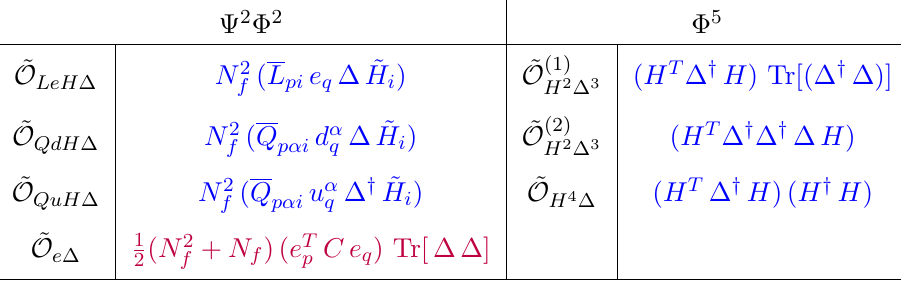
Table 6 . SM extended by Complex Triplet Scalar ( ∆ ): additional operators of dimension 5. Here i and α are SU(2) and SU(3) indices respectively. p, q = 1 , 2 , · · · , N f are the flavour indices. The operator in red violates lepton